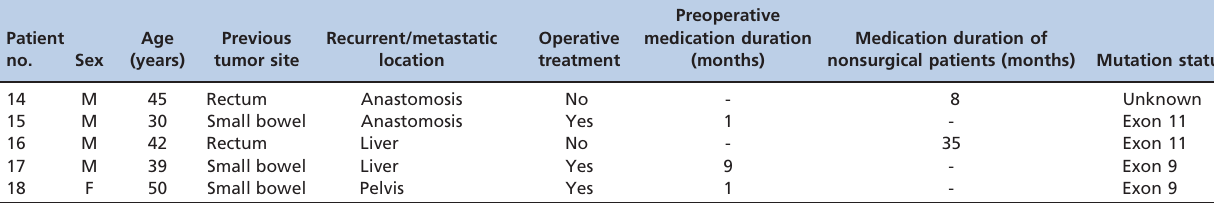
Table 2 - Main clinical characteristic of patients with recurrent/metastatic GIST. Patient no.